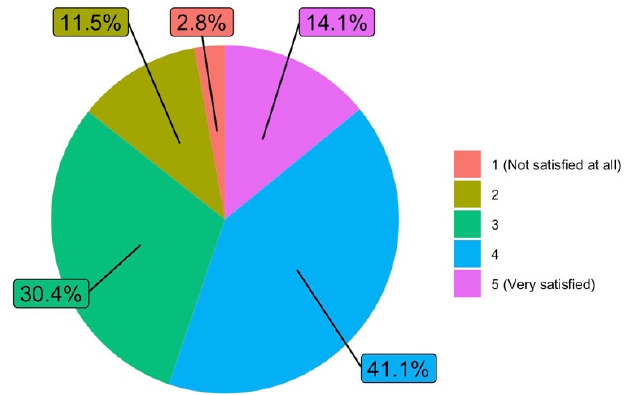
Figure 9. Degree of satisfaction of the teaching staff with the learning achieved by students (answers to Q10).